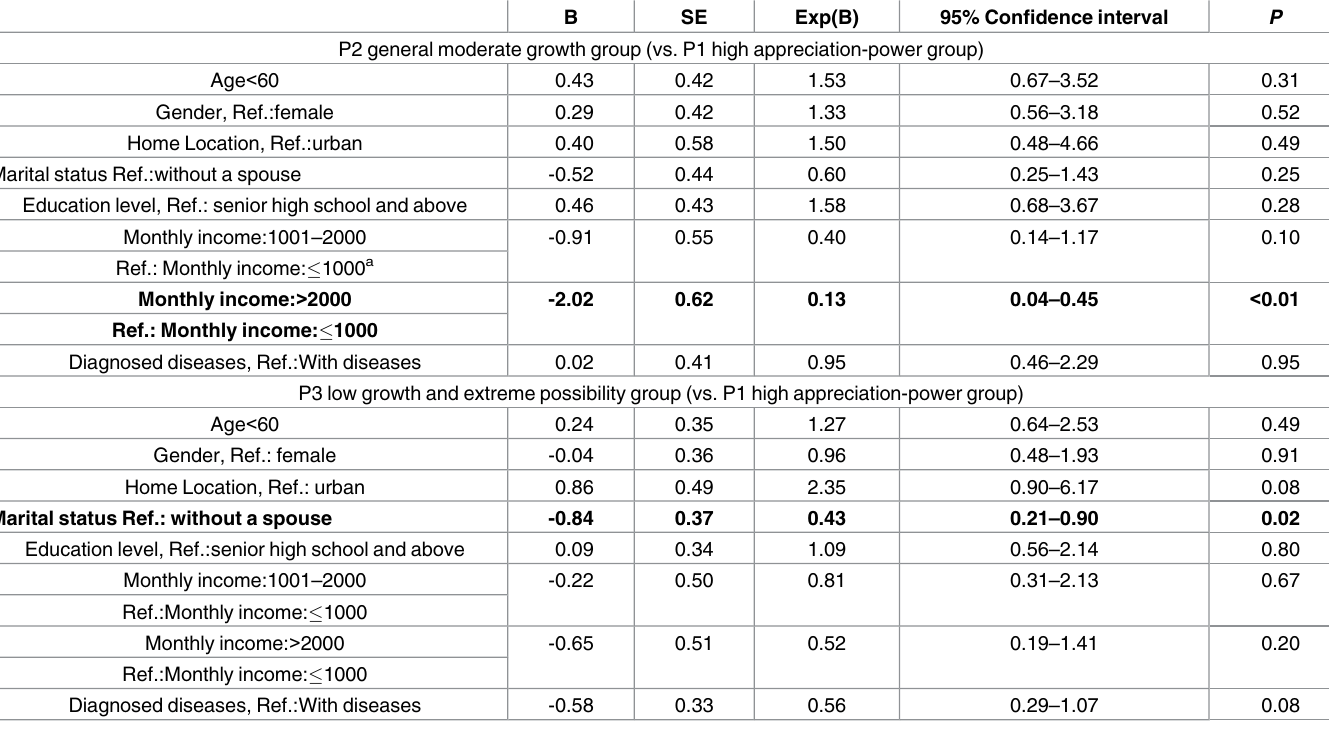
Table 3. Predictor of latent profile membership. B SE Exp(B) 95% Confidence interval